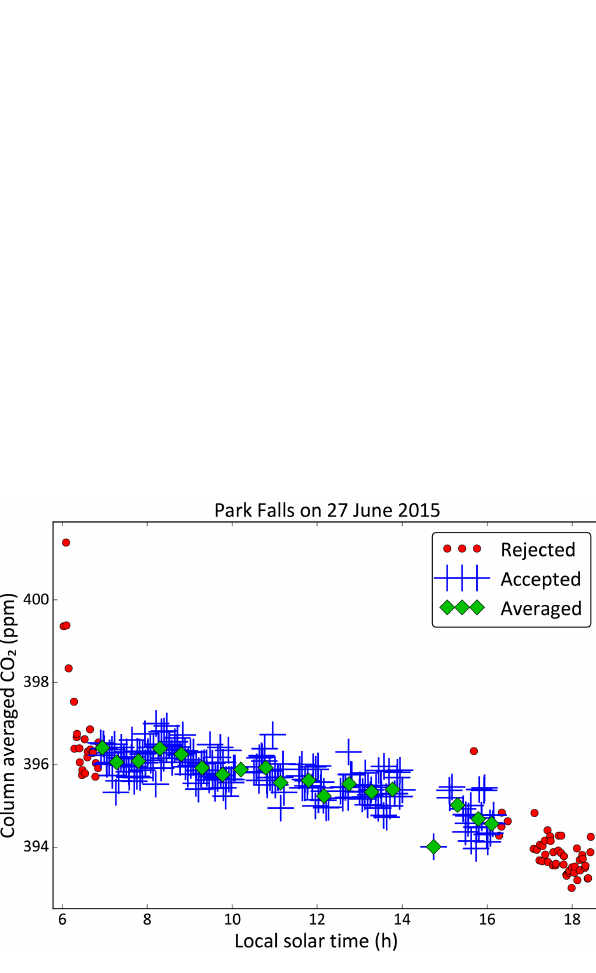
Figure C1. An example of TCCON X CO retrievals at Park Falls on 2 27 June 2015. Red circles denote retrievals that were rejected by the outlier filter, SZA filter, and TCCON flagging, while blue plus signs denote retrievals that passed those filters. Green diamonds denote the 30min averages of the accepted retrievals that were eventually used by the modelers for this